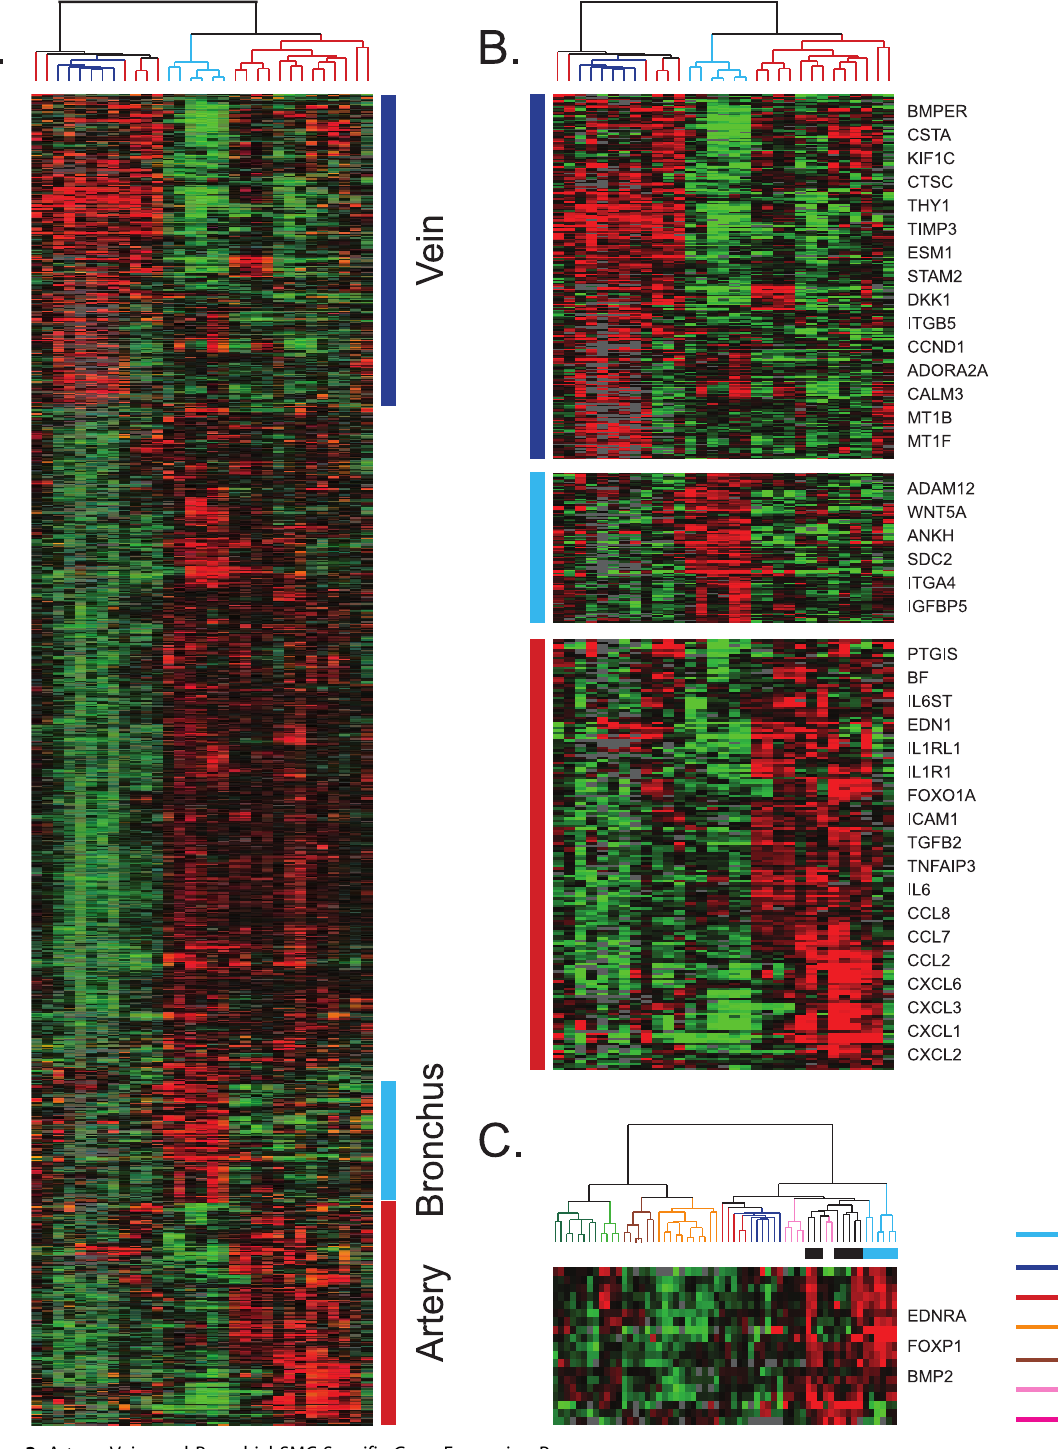
Figure 3. Artery, Vein, and Bronchial SMC-Specific Gene Expression Program (A, B) Artery-, vein-, and bronchus-specific genes were identified by a multi-class SAM analysis. The names of select vein-specific genes (blue bar), bronchus-specific genes (light blue bar), and artery-specific genes (red bar) are shown and expanded in (B). Complete data can be found on the supplementary Web site and SMD. (C) Features of a gene cluster with expression in lung tissues. Pulmonary artery clusters are marked by the black horizontal bar and bronchus clusters are marked by the light blue horizontal bar. Selected genes are shown.